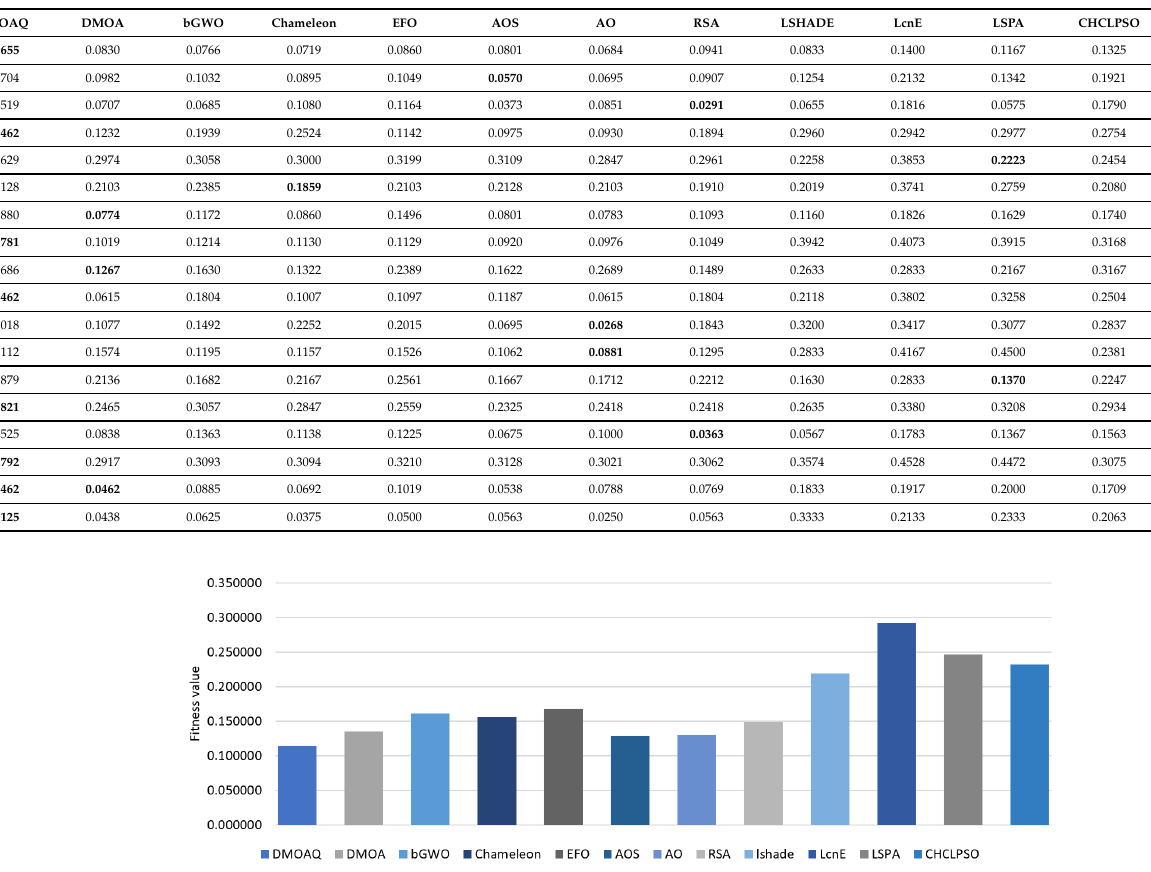
Figure 5. Average of maximum values of the fitness